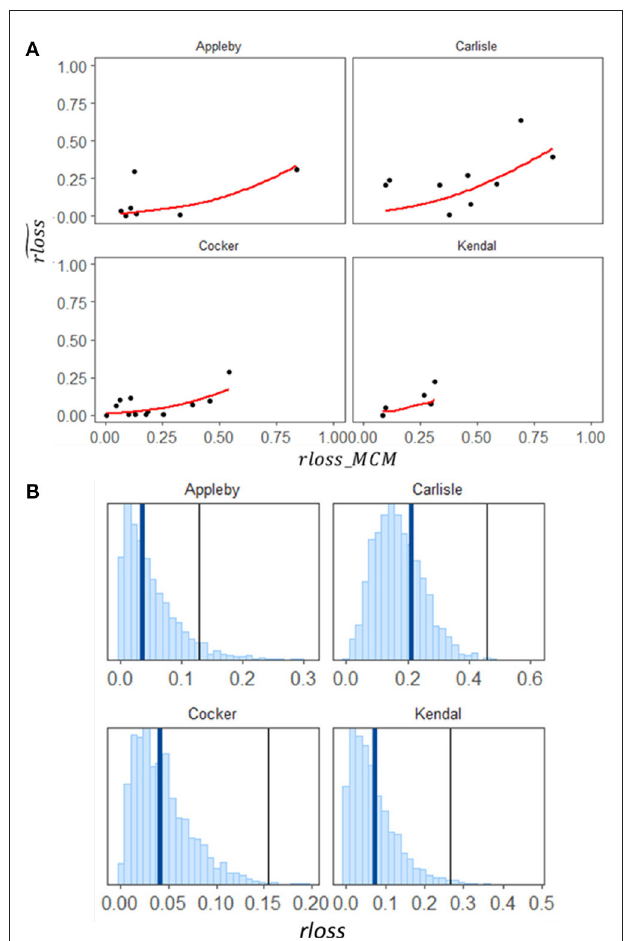
FIGURE 1 | (A) Region-wise scatter plot of MCM predictions against observed loss (black points) with reference 1:1-line (gray line) and predictions using hierarchical parameterization of the BDDS model (red line); (B) Region-wise posterior predictions using hierarchical parameterization of the BDDS model (histogram) along with median observed loss (blue line) and median of MCM estimate (black